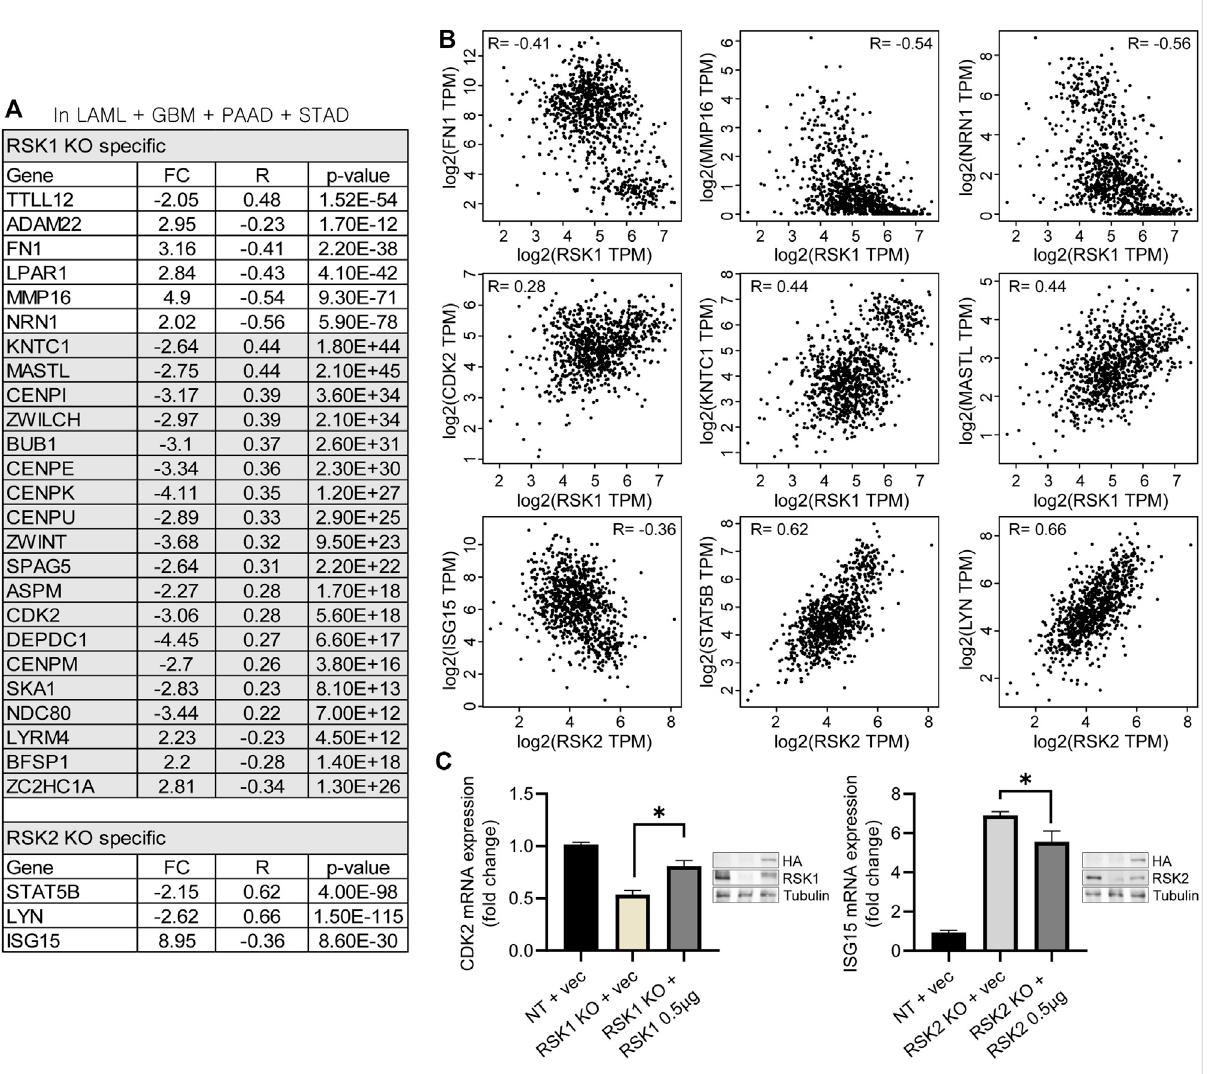
Correlation analysis of DEGs with RSK1 and RSK2. (A) Using the TCGA RNA sequencing expression data portal GEPIA2, listed DEGs were highly correlated with RSK1 or RSK2 expression from the TCGA data set. TCGA data sets were from Glioblastoma (GBM), Acute Myeloid Leukemia (LAML), Pancreaticadenocarcinoma(PAAD)andStomachadenocarcinoma(STAD)patients. GeneswereshownwithFC(foldchanged),Rvalueand p values. (B) RSK1 was negatively correlated with FN1, MM16 and NRN1, positively correlated with CDK2, KNTC1 and MASTL. RSK2 was negatively correlated with ISG15, positively correlated with STAT5B, and LYN. R: Spearman correlation coef fi cient. (C) CDK2 mRNA expression in RSK1 KO cells withrestoredRSK1(left)andISG15mRNAexpressioninRSK2KOcellswithrestoredRSK2(right).0.5 µgofRSK1andRSK2weretransientlytransfected for the assay. The expression of RSK1 and RSK2 protein was con fi rmed by western blot analysis. * = p <